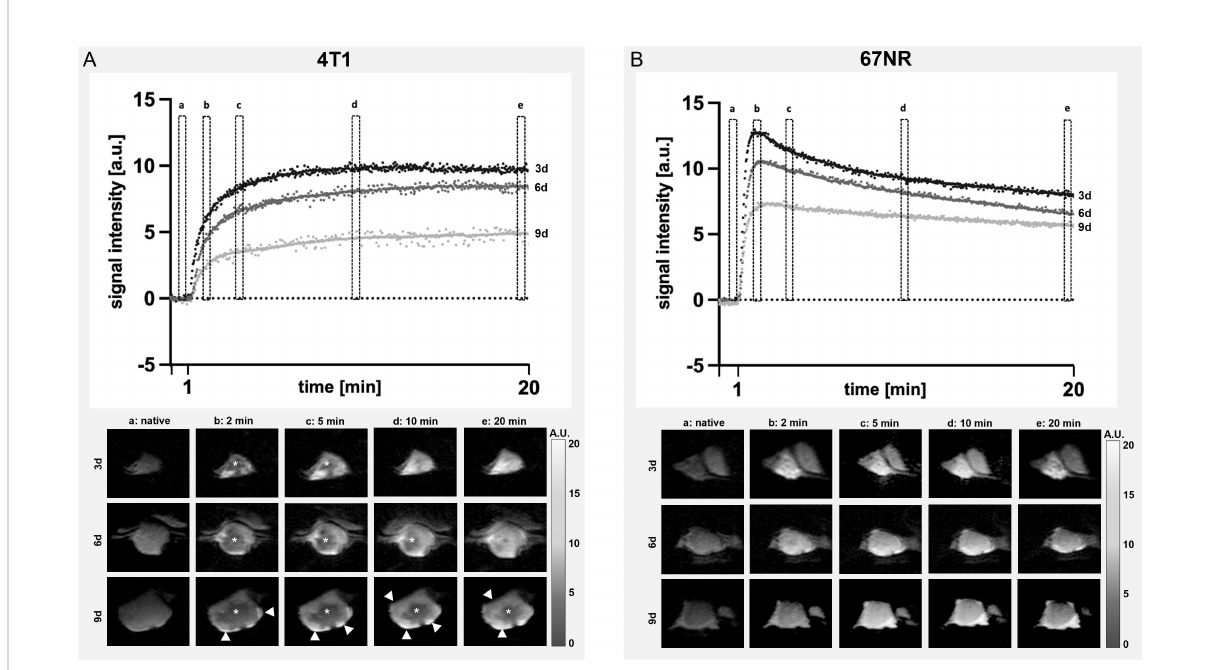
FIGURE 4 Assessment of contrast enhancement. Exemplary DCE curves of 4T1 (A) and 67NR (B) tumors on days three, six and nine and corresponding MR images show the differences in contrast enhancement, with a plateau in 4T1 (A) tumors, while 67NR (B) tumors exhibited a clear peak and a subsequent wash-out, which was more pronounced on day three in comparison to day nine. Images of the contrast enhancement of exemplary 4T1 and 67NR tumors show heterogeneous 4T1 tumors with a necrotic center (asterisks) and viable periphery (arrowheads), while 67NR tumors show a homogenous contrast agent enhancement. a – e are time points: a, native; b, 2 min; c, 5 min; d, 10 min; e, 20